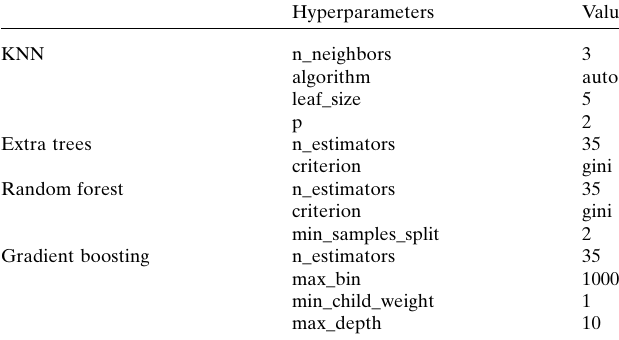
Table 3 Optimal hyperparameters of the SVM, KNN, extra trees, random forest and gradient boosting methods. Default values are used if they are not listed.